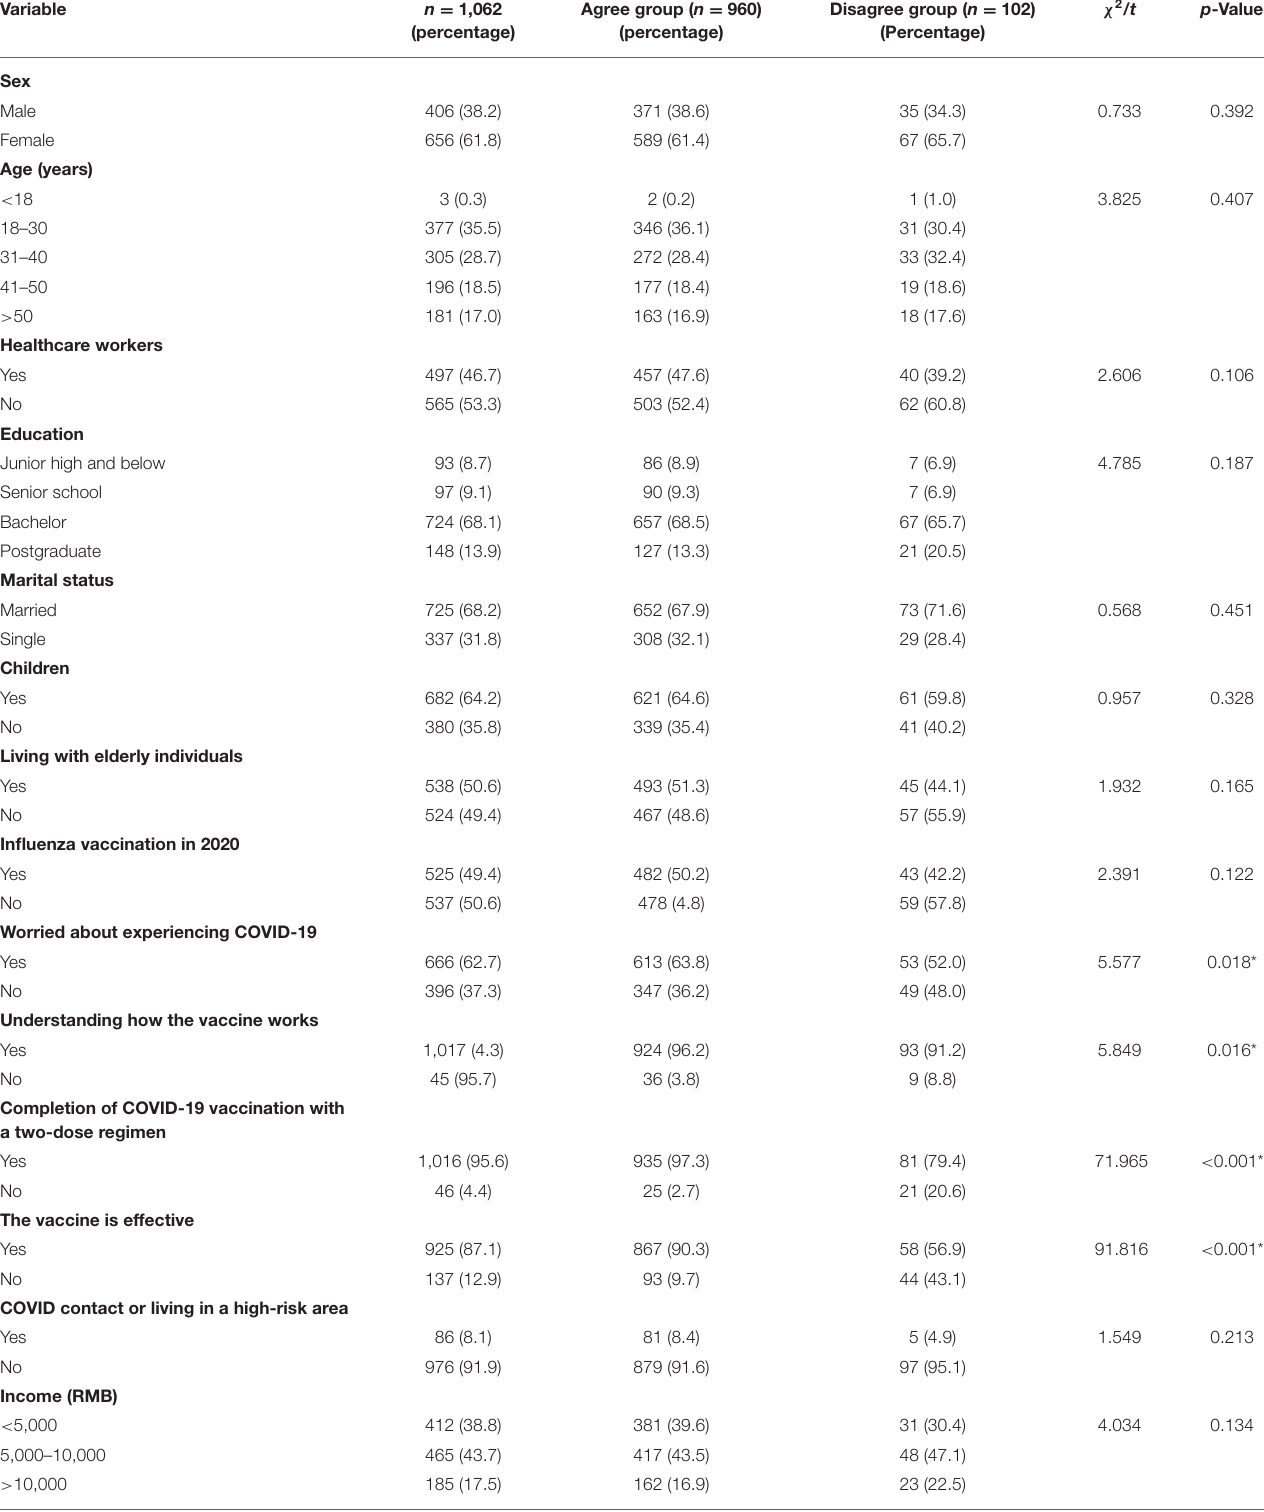
TABLE 1 | Demographics of study population and the univariate analysis between the agree and disagree groups ( n = 1,062).